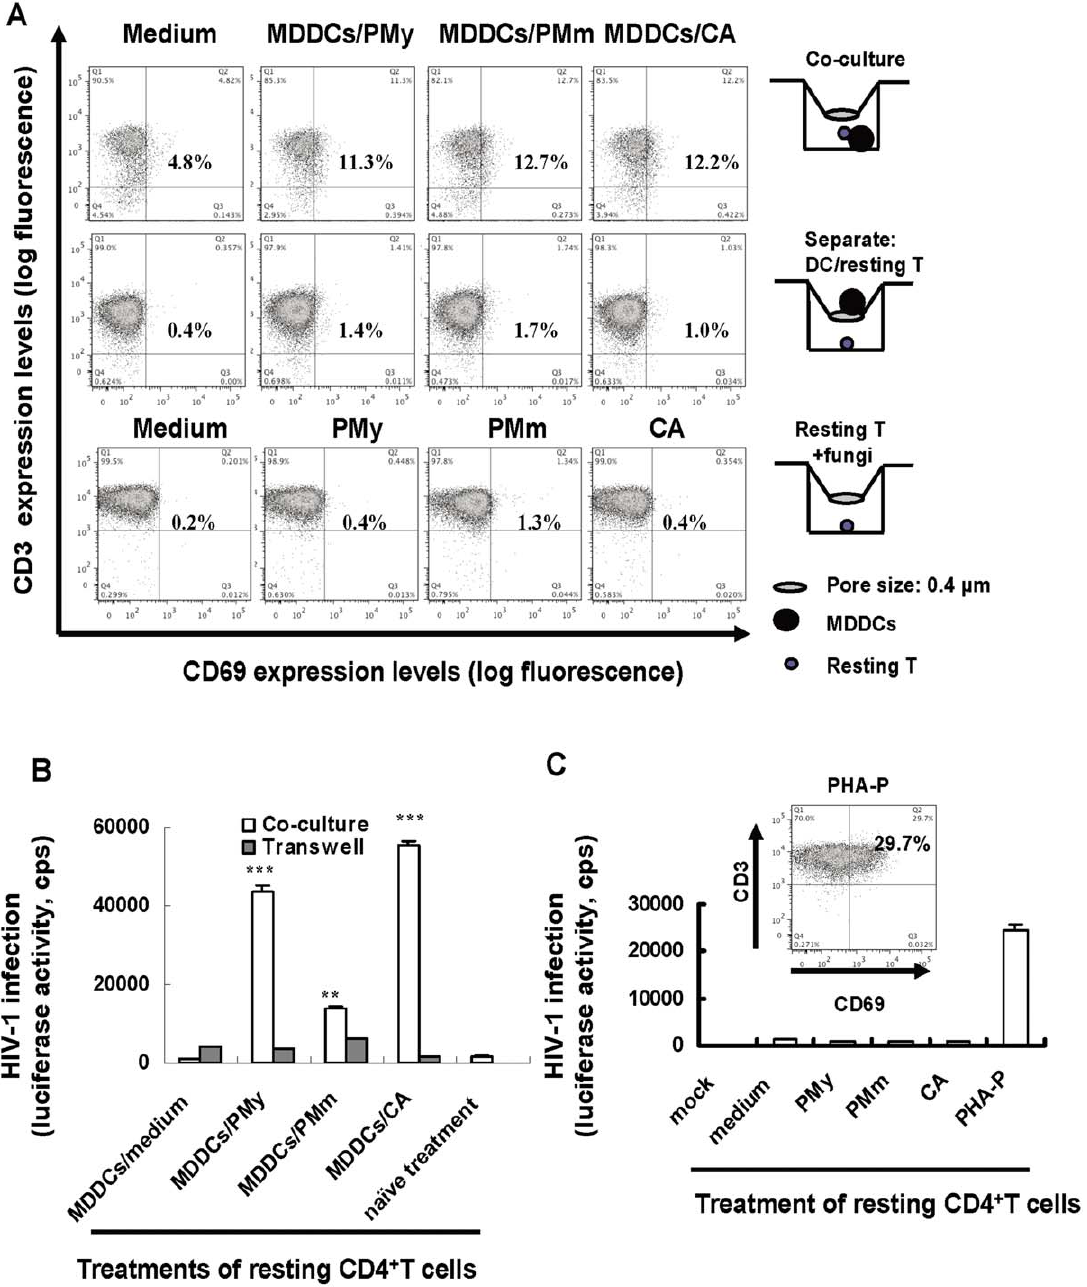
Figure 6. Fungus-loaded MDDCs facilitate the activation of resting CD4 + T cells and promote HIV-1 infection by activating more permissive cell targets. MDDCs were pulsed separately with heat-killed C. albicans , PMy, PMm or medium control for 2 h, then were co-cultured with same numbers of allogeneic resting CD4 + T cells. Transwell plates with membrane pore sizes of 0.4 m m were used to separate MDDCs from T cells. The activation of resting T cells directly stimulated with fungi was also checked. After additional 48 h incubation, T cells were gated by a CD3 + cell population to detect CD69 expression by flow cytometry (A). CD4 + T cells were purified with magnetic micro-beads, pulsed with 5 ng p24 gag amounts of pseudotyped HIV-Luc/NL4-3 for 2 h, and HIV-1 infection was detected 3 days later by measuring the luciferase activity in cell lysates (B, C). Asterisks indicate significantly enhanced HIV-1 replication in T cells activated by fungus-stimulated MDDCs during co-culture, relative to that in medium-treated MDDCs (** P , 0.01, *** P , 0.001, paired t test). Direct treatment of heat-killed fungi neither activated resting T cells nor enhanced T- cell susceptibility to HIV-1 infection. PHA-P was used as a positive control for non-specific activation of resting T cells, and the positive percentages of CD69 are shown in (A) and (C). Results of one representative experiment out of three are shown. Data are mean 6 SD. doi:10.1371/journal.pone.0027609.g006 with the plasmid pLAI- D -env-Luc and expression plasmids of (VLPs), HIV-1-Gag-GFP/JRFL, were generated by cotransfection either JRFL (R5-tropic) or NL4-3 (X4-tropic) envelope glycopro- of HEK293T cells with a plasmid encoding HIV-Gag-GFP and teins as described previously [27,31,32]. Virus like particles with an expression plasmid of JRFL (kind gifts from Dr. Vineet